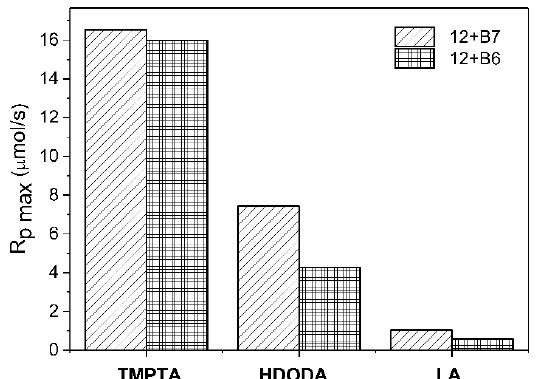
Figure 6. Comparison of the mono-, bi- and tri-functional acrylate monomers polymerization initiated by merocyanine—borate salt pairs. B7 designation refers to the tetramethylammonium phenyltributylborate and B6 to the tetramethylammonium phenyltriethylborate applied as co-initiator with the 12 dye. They concentration was 0.05 M and the light intensity was 100 mW/cm 2 .